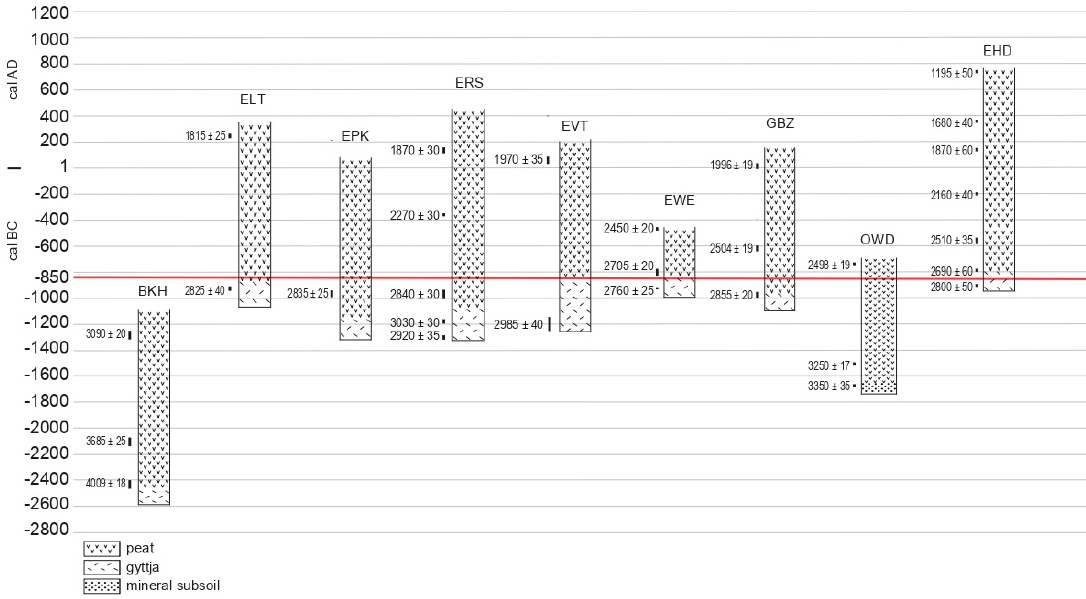
Figure 6. The base of the organic accumulation (gyttja and subsequently peat) at the sites Berkhout (BKH), ELT, EPK, ERS, Enkhuizen-Vijzeltuin (EVT), EWE, GBZ, Oostwoud (OWD) from this study and Enkhuizen-Dijk (EHD [17]) along a calendar time axis. The conventional radiocarbon ages (in BP) are indicated at the most probable calendar time position. The red line indicates 850 cal BC, and the illustration shows that at several sites inundation already started before 850 cal BC.